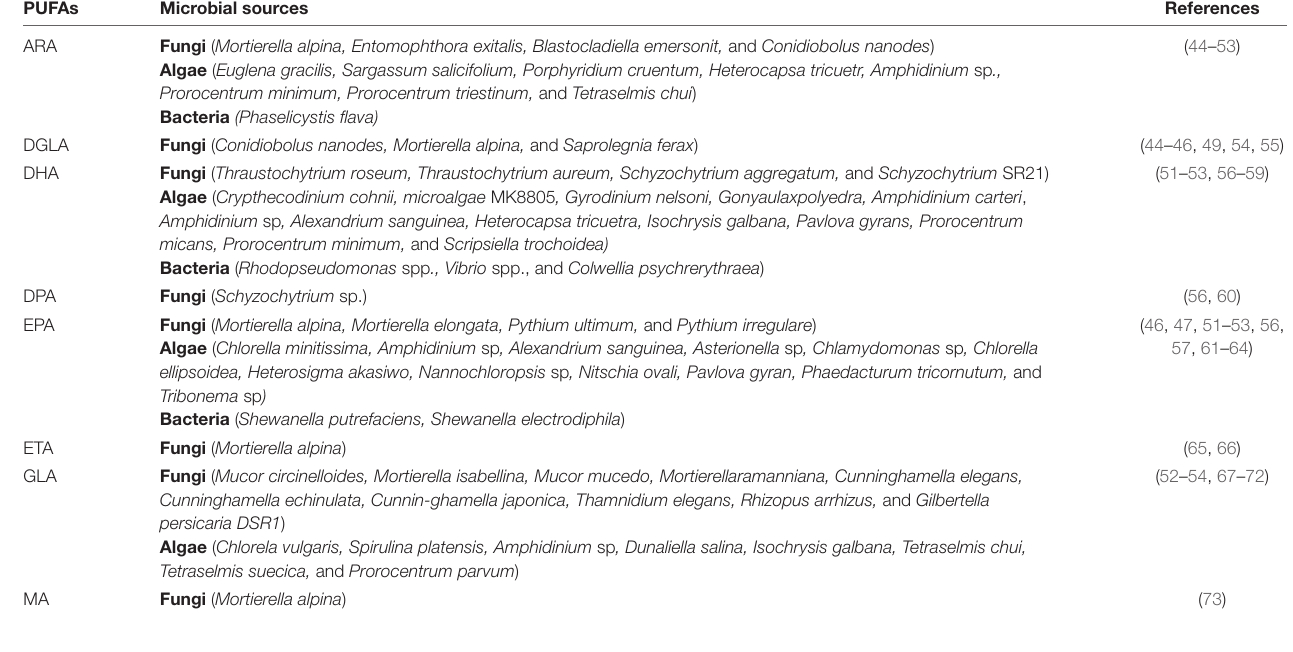
TABLE 2 | List of oleaginous microbes in nature capable of synthesizing and storing PUFAs. PUFAs Microbial